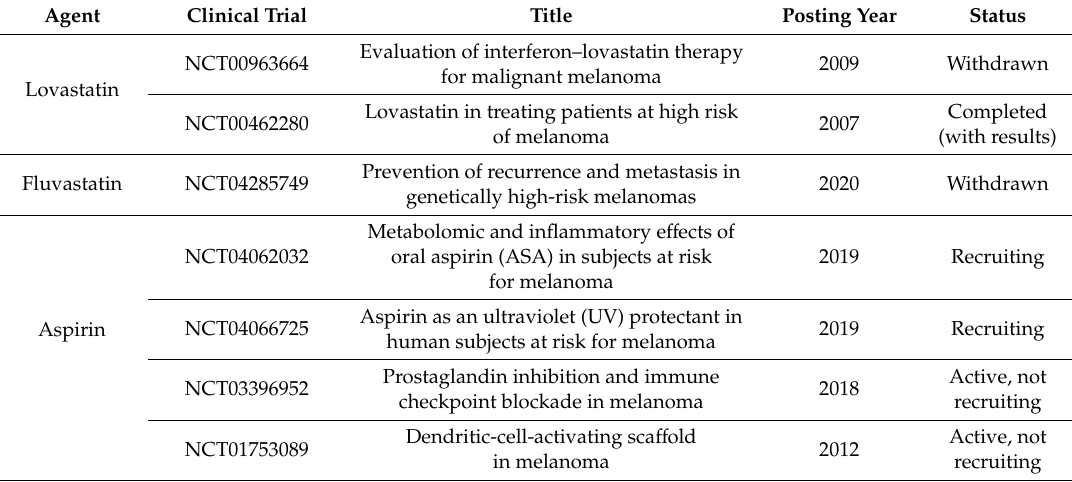
Table 3. Clinical trials evaluating lipid-metabolism-targeting drugs in melanoma. Data were extracted from ClinicalTrials.gov database (https: //